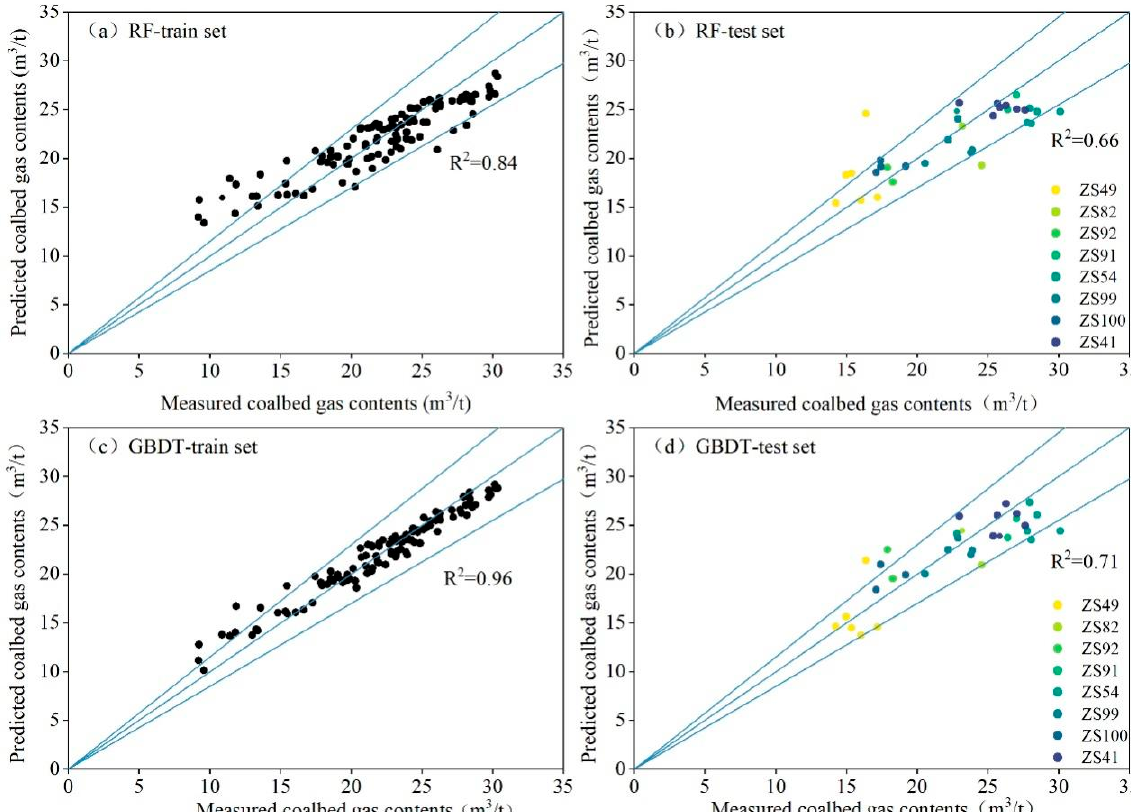
Figure 7. Performance of RF and GBDT models in training and test sets. Table 2. The importance of different hyper-parameter in the RF model and GBDT model.